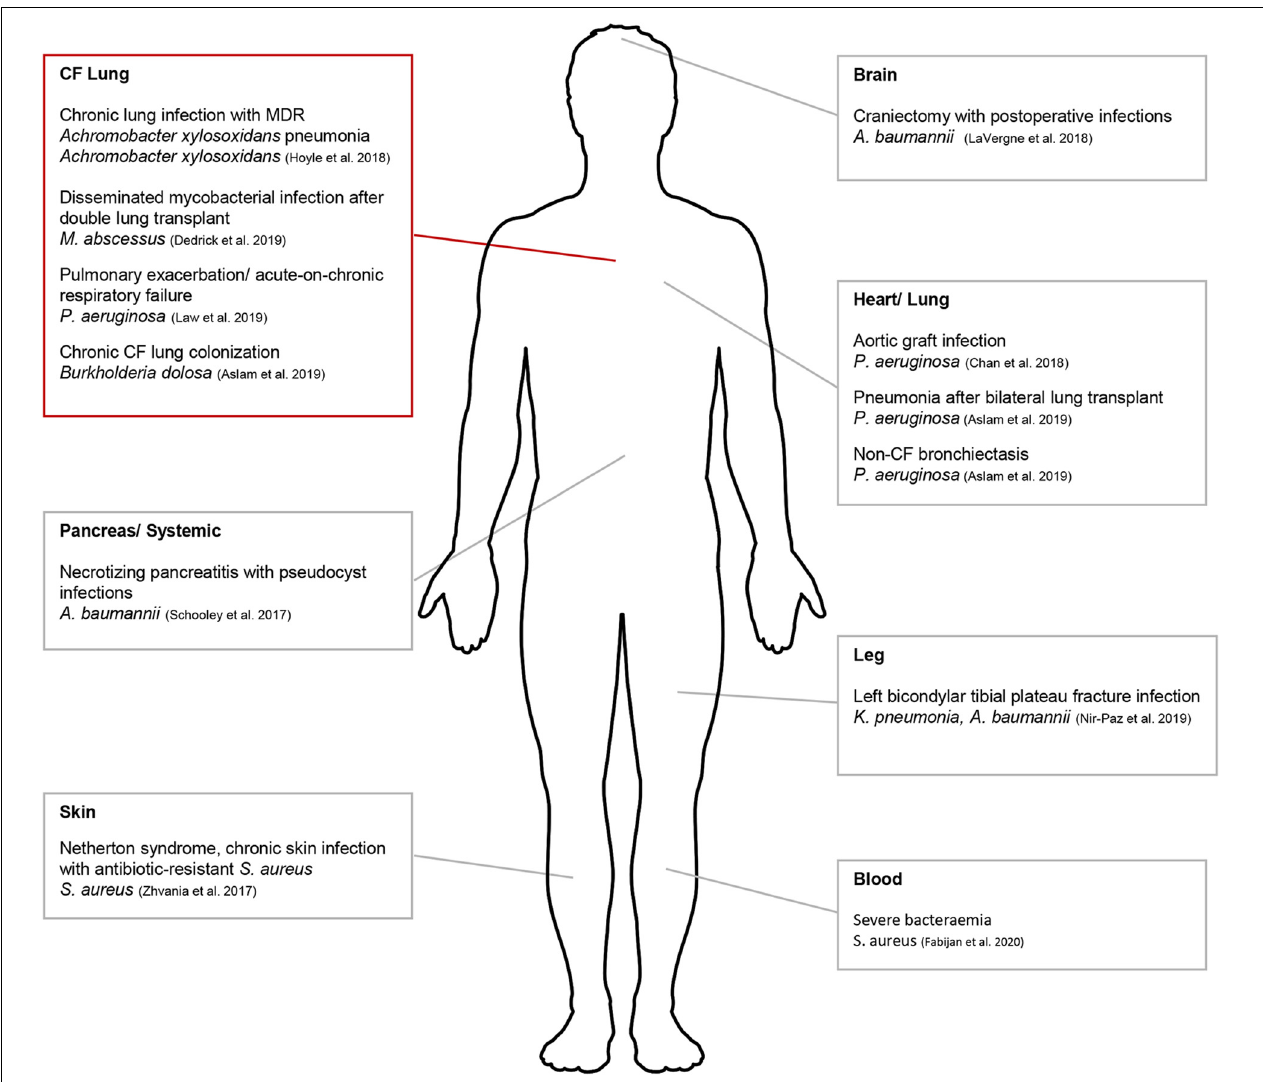
FIGURE 1 | Schematic diagram indicating areas where phage therapy had been applied clinically for compassionate use. Compassionate use in CF denoted by red box. This figure was created using Servier Medical Art templates, which are licensed under a Creative Commons Attribution 3.0 Unported License;